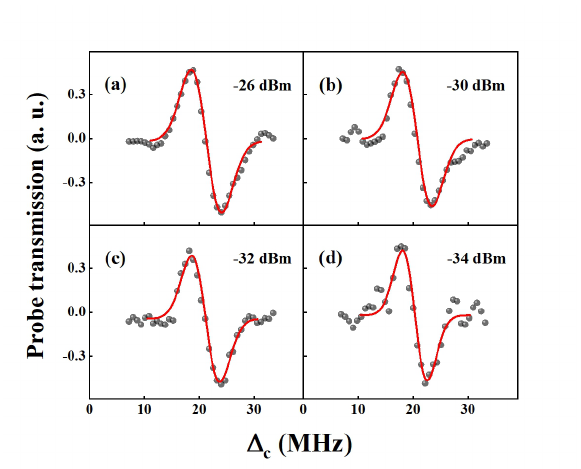
Figure 5. The right transmission signals of the AT splitting with different microwave E-fields. ( a ) − 26 dBm; ( b ) − 30 dBm; ( c ) − 32 dBm; ( d ) − 34 dBm. The black dots are the experimental results and the red lines are the fittings with Voigt